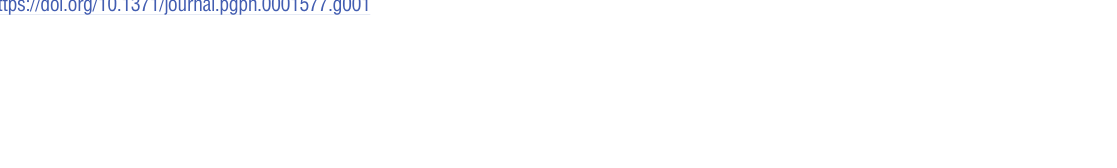
PLOS Global PublicHealth | https://doi.org/10.1371/journal.pgph.0001577 February 23,